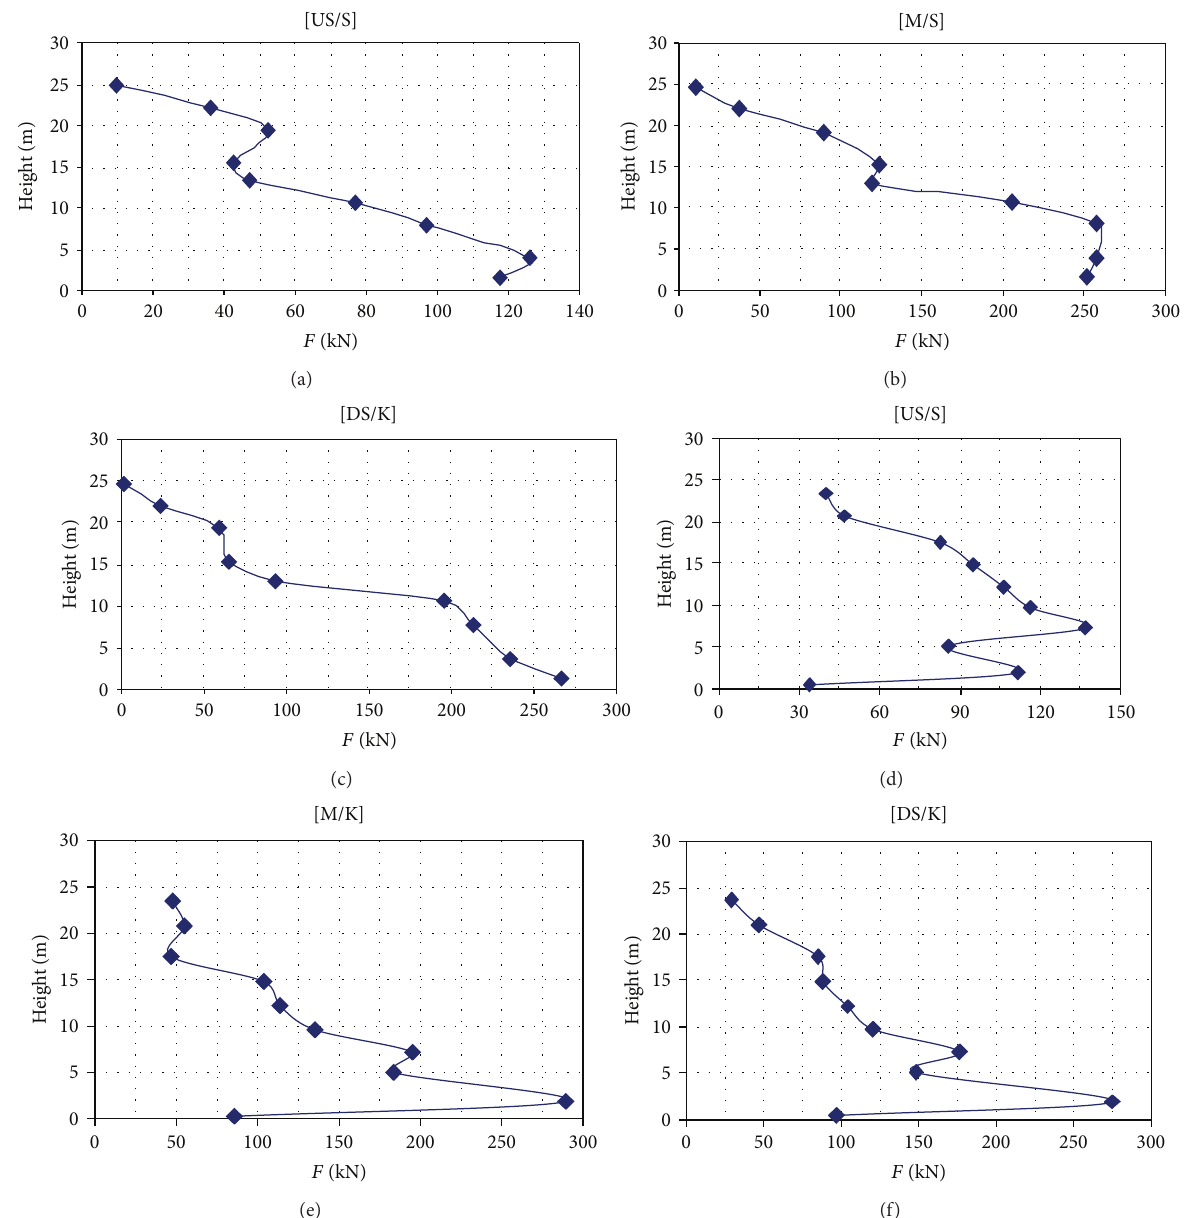
Figure 14: Equivalent force curves for various parts of Upper San Fernando (S) and Kitayama (K) dams.